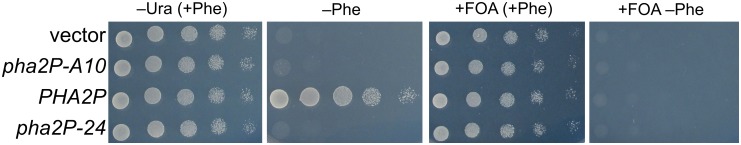
Only PHA2P but not pha2 mutant alleles compensate for the pheA10 phenylalanine auxotrophy.33G-D373 was transformed with plasmids bearing indicated PHA2 alleles. Series of 5-fold dilutions on synthetic media are shown. Vector, pRS316.